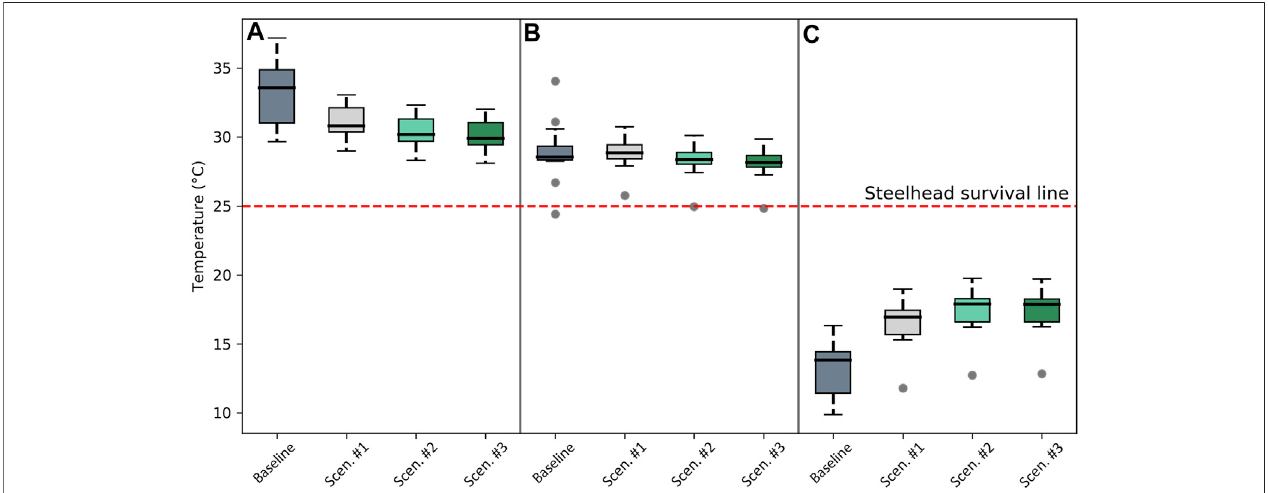
FIGURE 4 | Boxplots showing the variation of the thermal metrices for the base case condition and under 3 applied scenarios. The fi gure shows the variation of three de fi ned metrics MaxWMT (A) , MaxWAT (B) , and MinWMT (C) for the simulations in the migration season (February 1 – May 31, 2016). The red dashed line shows the maximum temperature a steelhead could tolerate.